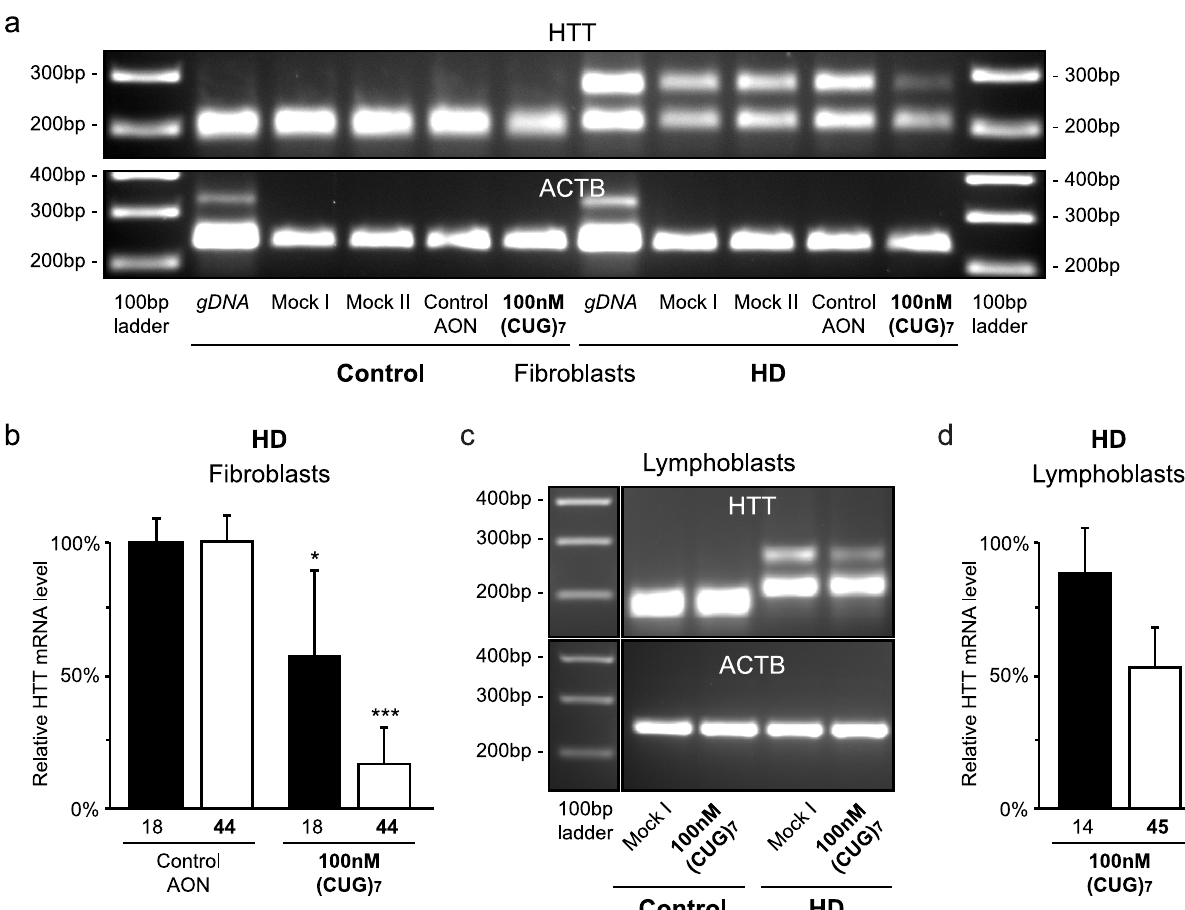
Figure 2. Effect of (CUG) 7 AON on HTT mRNA levels in HD patient derived cell lines 48 hours after transfection. Cells were transfected with 100 nM (CUG) 7 , non-htt specific h40AON2 (Control AON), transfection agent only (Mock II), or non-transfected cells (Mock I). (a) Agarose gel analysis of the HTT transcript with primers flanking the CAG repeat of control (FLB73) and HD (GM04022) fibroblasts treated with various AONs. Transfection with (CUG) 7 shows a decrease of the upper band, representing the transcript from the mutant allele. The lower band, representing the normal HTT transcript, is also reduced, but to a lesser extent. Control cells treated with (CUG) 7 only show a slight reduction compared to the control transfections. PCR products with primers for ACTB were used as loading control. gDNA was taken along to control for the PCR reaction over the CAG repeat. (b) Lab-on-a-Chip analysis of HTT transcripts after (CUG) 7 treatment in a HD fibroblast cell line. The mutant transcript, with 44 CAGs, is significantly reduced by 83% after (CUG) 7 treatment, compared to transfection controls. The normal HTT transcript with 18 CAGs is reduced by 43%. Expression levels are corrected for loading differences with ACTB. The mRNA level of the Mock I transfection was set on 100% (* P , 0.05, *** P , 0.001, n=4). (c) Agarose gel analysis of HTT transcripts after (CUG) 7 treatment in EBV transformed control and HD human lymphoblasts. After transfection with (CUG) 7 the mutant HTT transcript with 45 CAGs is decreased compared to the Mock transfection. No changes in intensity of the HTT transcripts from the control lymphoblasts are seen after (CUG) 7 treatment. (d) Lab-on-a-Chip analysis of HTT transcripts after PS57 treatment of human HD lymphoblasts. Mutant HTT transcript is reduced by 46% after (CUG) 7 treatment, whereas the normal HTT allele shows an 11% reduction. (n=2)